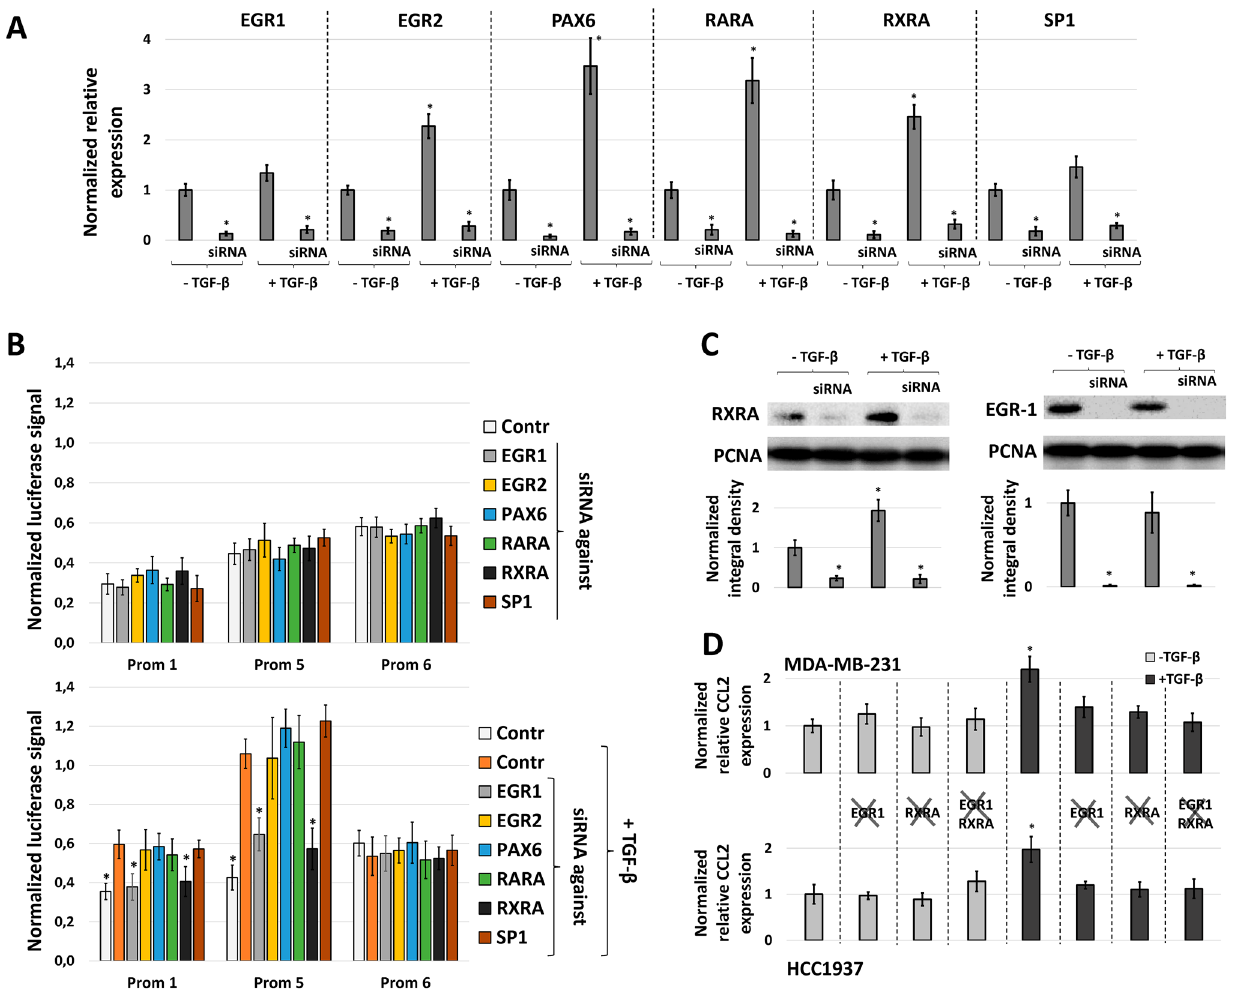
Figure 4. Knock-down of EGR1 and RXRA transcription factors resulted in the independence of the CCL2 promoter of TGF-β1 activation in MDA-MB-231 breast cancer cells. ( A ) The efficiency of knock-down of EGR1, EGR2, PAX6, RARA, RXRA, and SP1 genes after transfection of MDA-MB-231 cells with specific siRNAs in the presence or absence of TGF-β1 activation was tested by real-time PCR. For each gene, the normalization to the sample without siRNA and TGF-β1 was performed (the meanings for these samples are represented as 1). The real-time PCR data are represented as the mean ± SEM (five independent experiments). *P < 0.01 in respect to control without siRNAs and TGF-β1. ( B ) Prom 1, Prom 5, and Prom 6 CCL2 promoter variants were tested using a luciferase reporter assay in MDA-MB-231 cells transfected with specific siRNAs in normal conditions (top panel) or in the presence of TGF-β1 (10 ng/mL, 24 h) (bottom panel). The data were obtained in seven independent experiments and normalized to the Renilla luciferase activity. *P < 0.01 in respect to control with TGF-β1. ( C ) EGR1 and RXRA protein levels measured in nuclear extracts of MDA-MB-231 cells in the presence or in the absence of specific siRNAs and/or TGF-β1 (10 ng/mL, 24 h). The experiment was repeated for three times. Representative western blots are shown (upper panel). For the detection of RXRA, EGR1 and PCNA proteins the membranes were splitted horizontally into two pieces. The upper piece of each membrane was stained with anti-RXRA or anti-EGR1 primary antibodies, and the lower—with anti-PCNA antibodies. Chemiluminescent detection of the bands was performed using ChemiDoc Imager (Bio-Rad Laboratories, Hercules, CA, USA). Full-size images of splitted membranes are represented in Supplementary Fig. S2. Membrane images were quantified using ImageJ software (bottom panel). Integral densities for EGR1 and RXRA bands normalized to PCNA in MDA-MB-231 cells without TGF-β1 activation are represented as 1. *P < 0.01. ( D ) CCL2 mRNA levels were estimated by RT PCR in real time. For each cell line, samples without siRNAs and TGF-β1 are represented as 1. The results of three independent experiments are shown. The full- length blot images are represented in Supplementary Fig. S2. *P < 0.01 as compared to control without siRNAs and